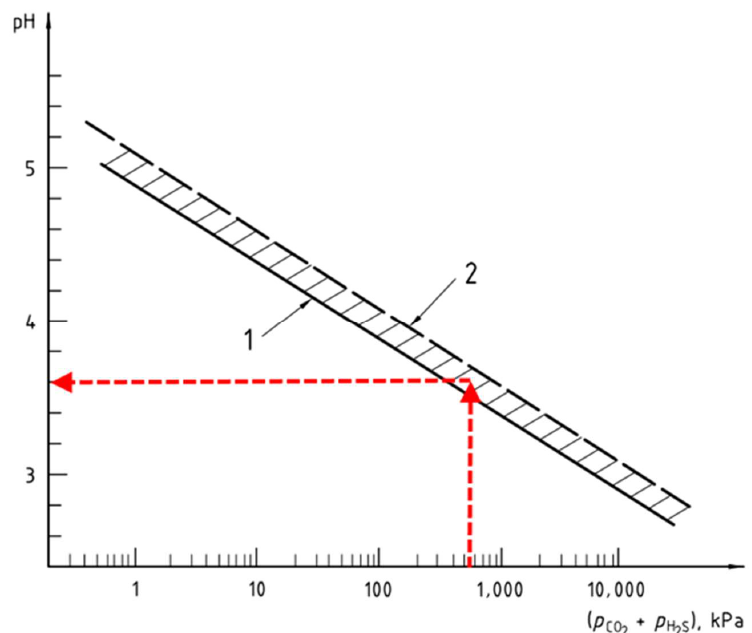
Figure 10. Environment pH vs. partial pressure of H 2 S and CO 2 [5].